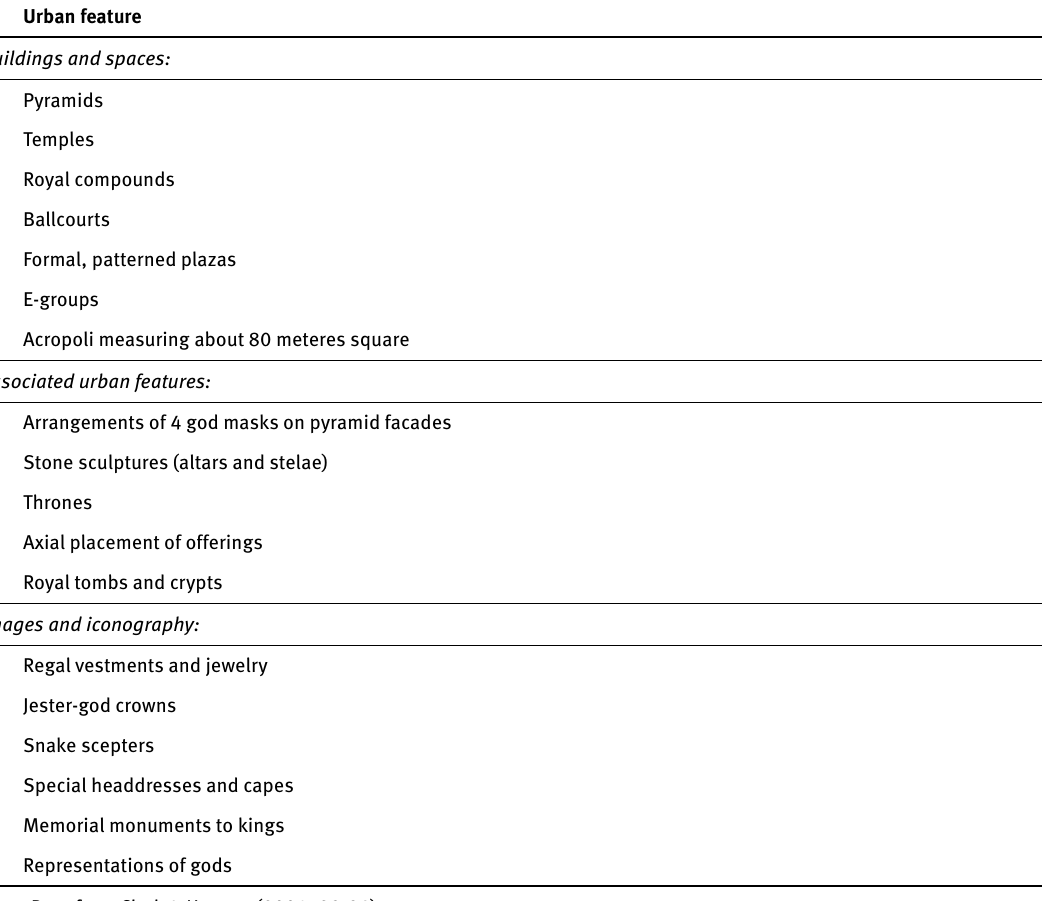
Table 1. Preclassic Mesoamerican urban